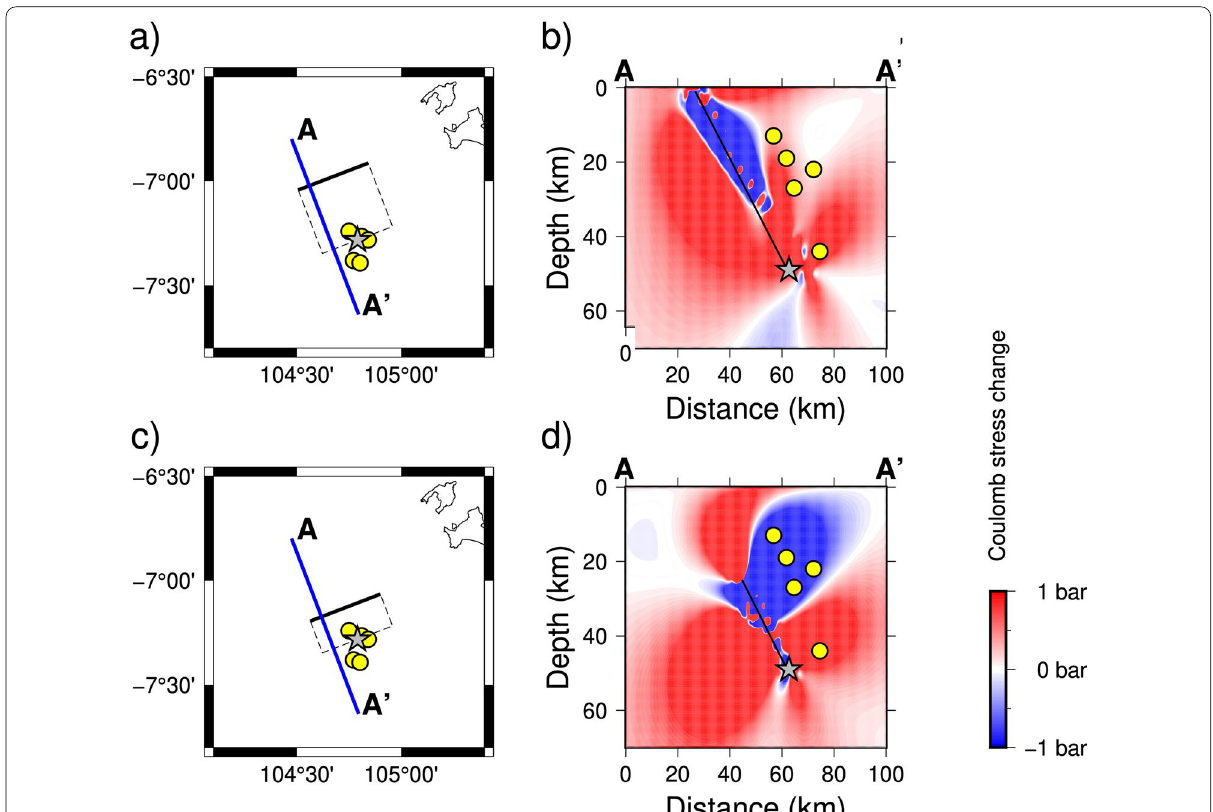
Fig. 10 Relocated aftershocks distribution from 3—16 August 2019 and Coulomb stress change analysis correspond with fault a , b Model 1A, c , d Model 1B. a , c Distribution of the relocated aftershocks are shown by yellow circles; b , d The vertical view of calculated Coulomb stress change along profile